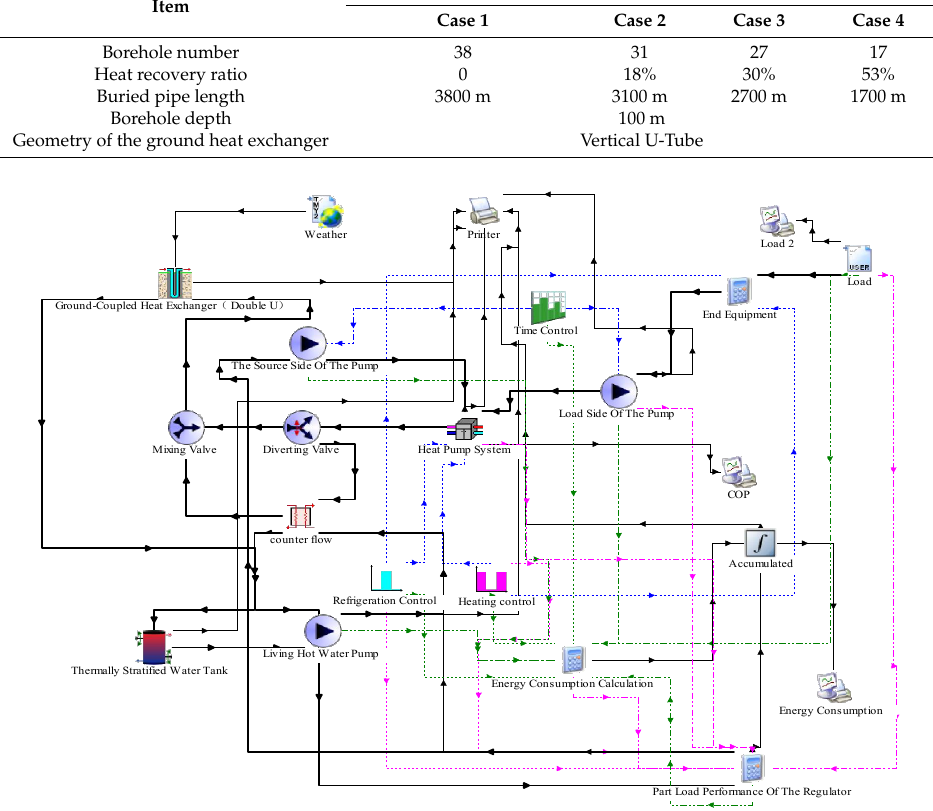
Figure 2. Model of the hybrid ground source heat pump system (GSHPS). Energies 2018 , 11 , x